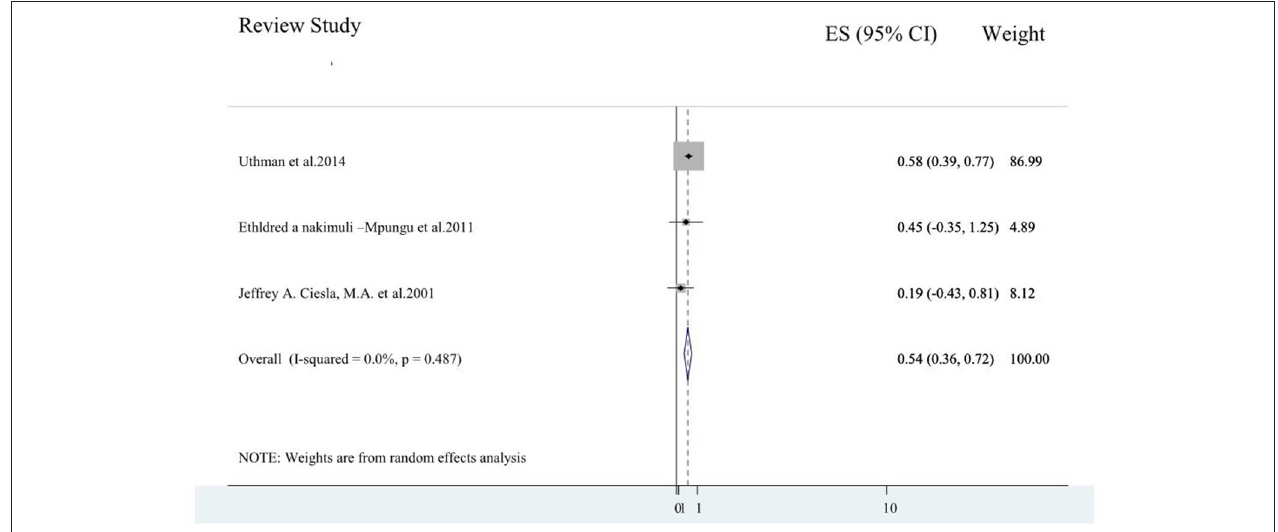
FIGURE 5 | A forest plot for the systematic review of reviews of effects of depressive symptoms on antiretroviral medication